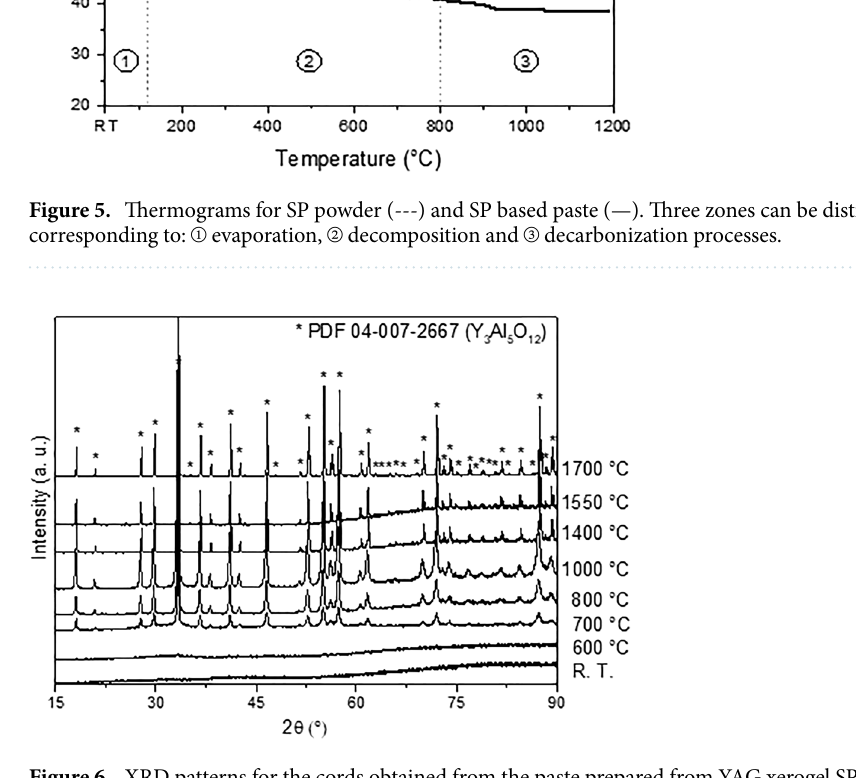
Figure 6. XRD patterns for the cords obtained from the paste prepared from YAG xerogel SP after calcination in air at different